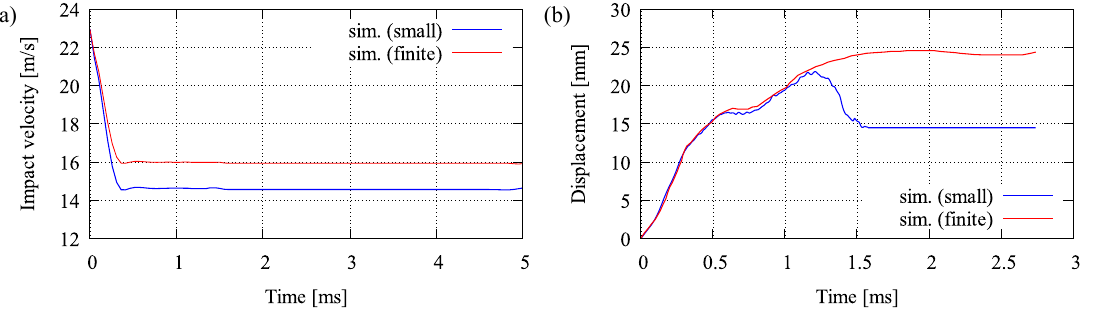
Figure 18. Simulation results comparing small and finite strain model: ( a ) velocity-time and ( b ) displacement-time